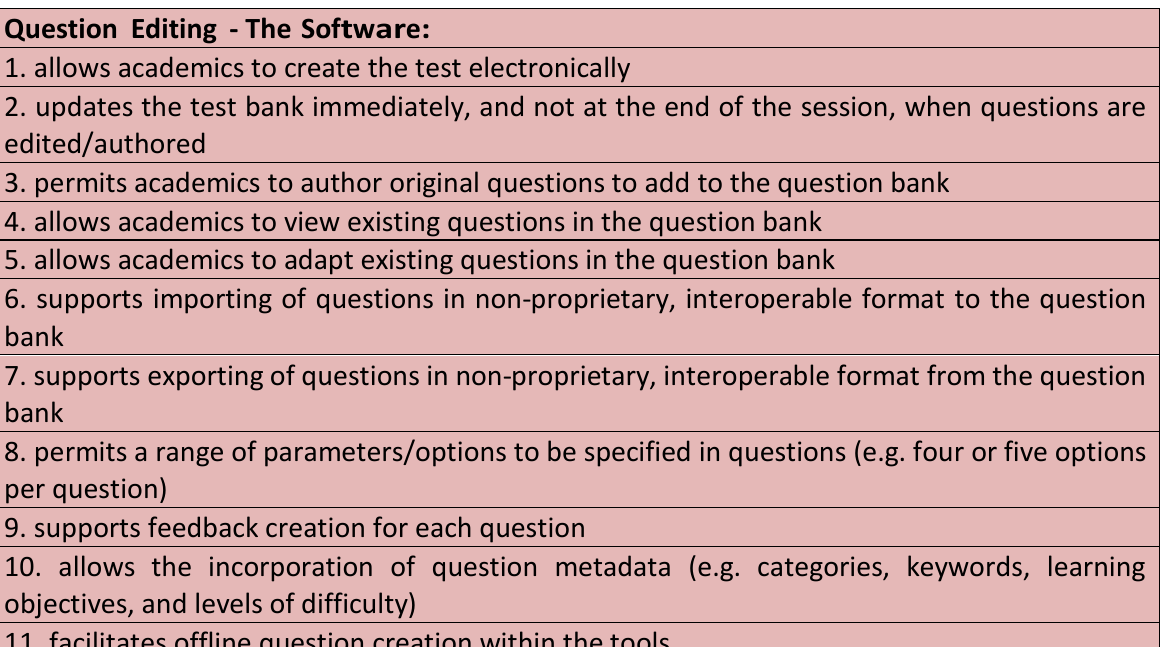
Table 3 e- SEAT’s Functional